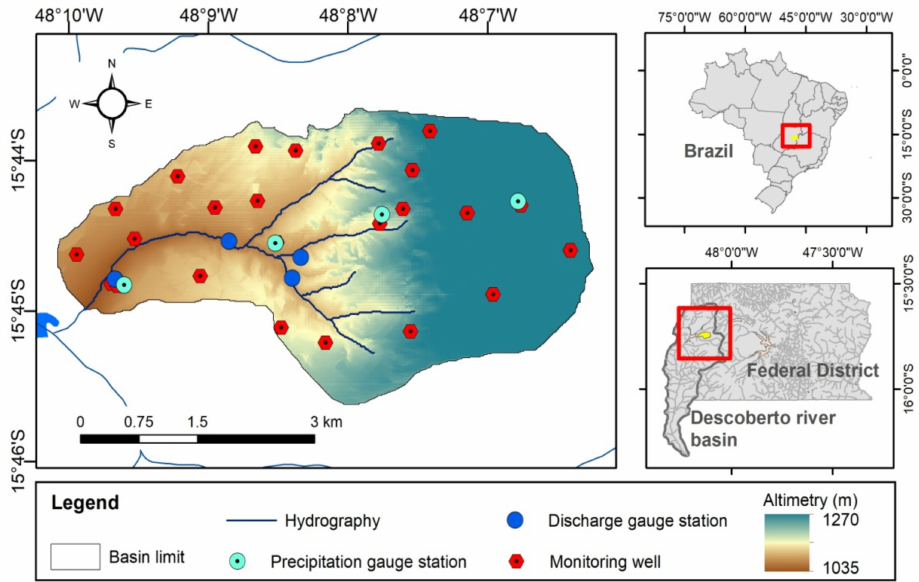
Figure 1. Location of the study